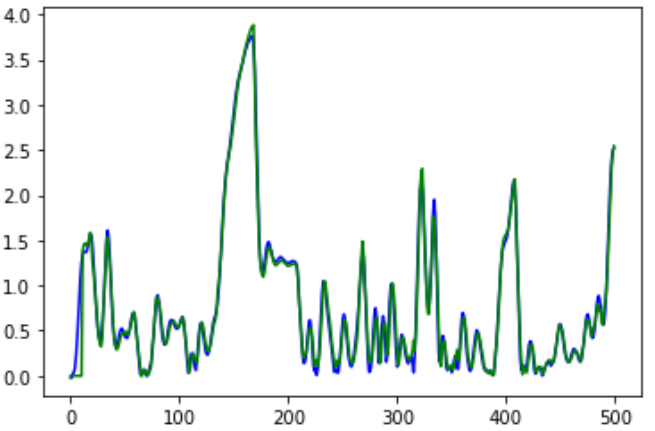
Figure 13. Output from prediction (green) using the best found individual for the Coupled Drives problem, compared to the empirical data (blue).